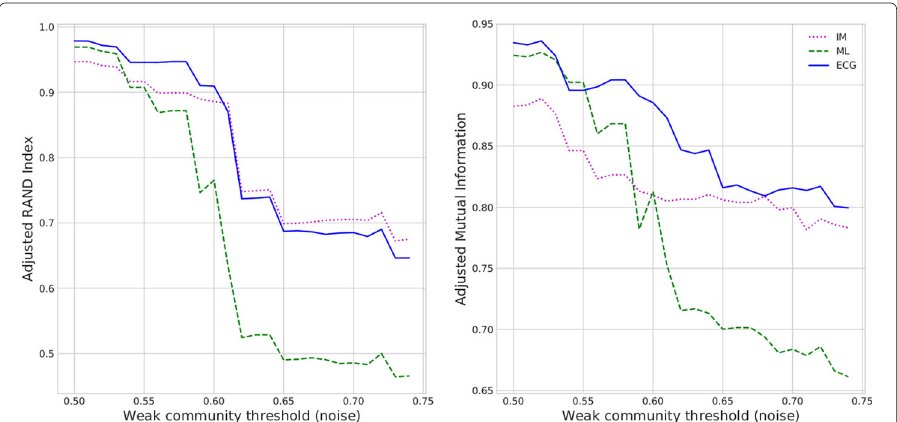
Fig. 8 We compare the partitions obtained with ECG, Louvain (ML) and Infomap (IM) over the Youtube graph. We only consider the groud-truth communities where the ratio of external to total degree is below some threshold, which we vary from 0.5 to 0.75 on the x-axis. Results are compared via the ARI and AMI